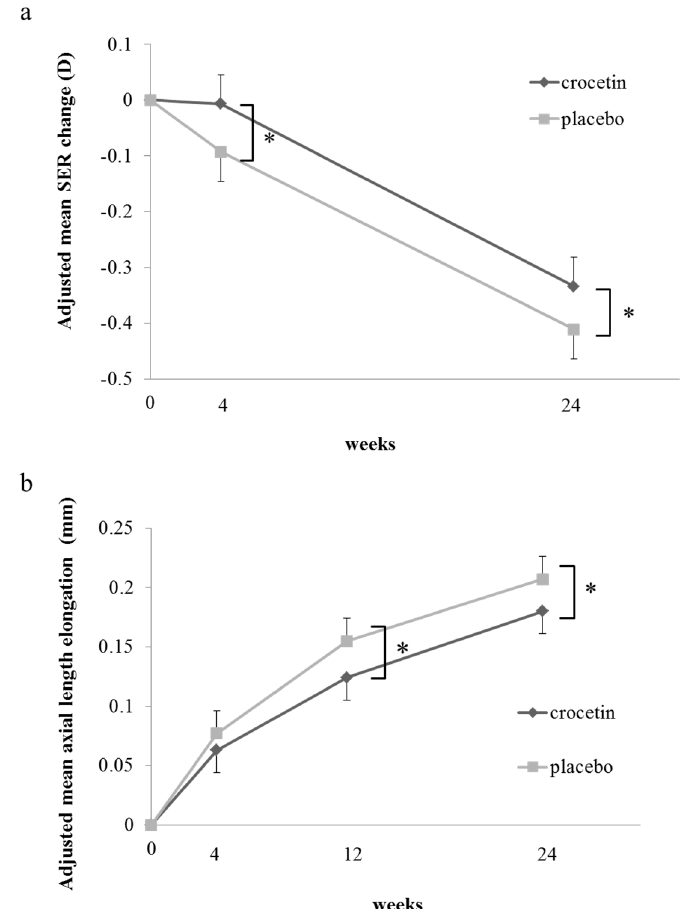
Figure 2. Time course of the adjusted mean spherical equivalent refraction (SER) change ( a ) and axial length elongation ( b ).